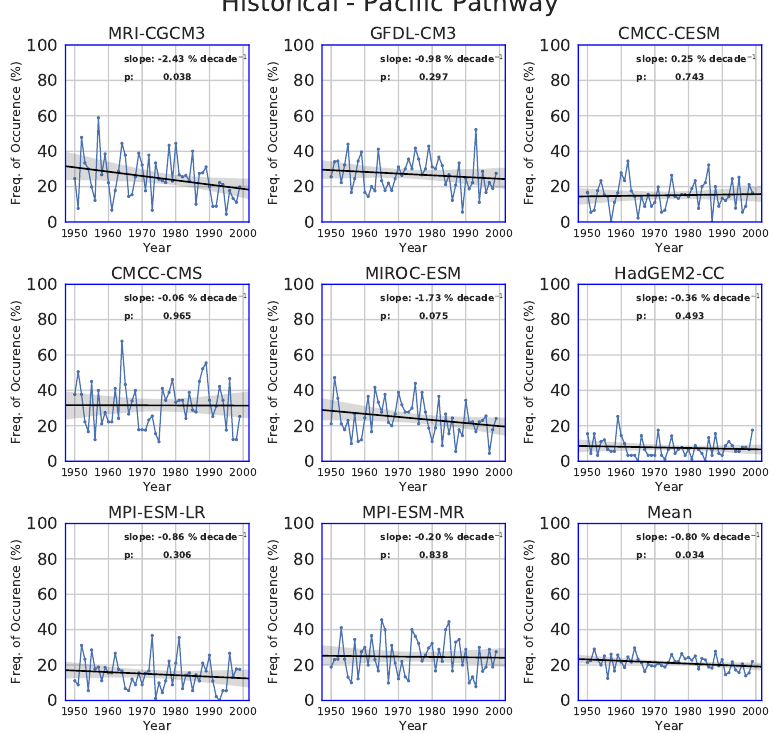
Figure 10. Same as in Figure8, but for the Pacific